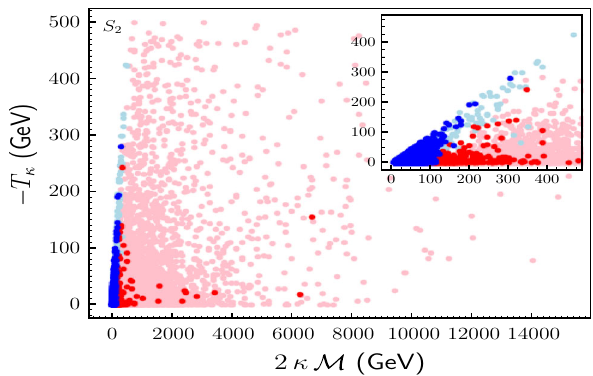
versus Fig. 11 Viable points of the parameter space for S 2 in the − T κ versus 3 2 κ M plane. The color code is the same as in Fig. 8. In the upper right we zoom in the region with blue points